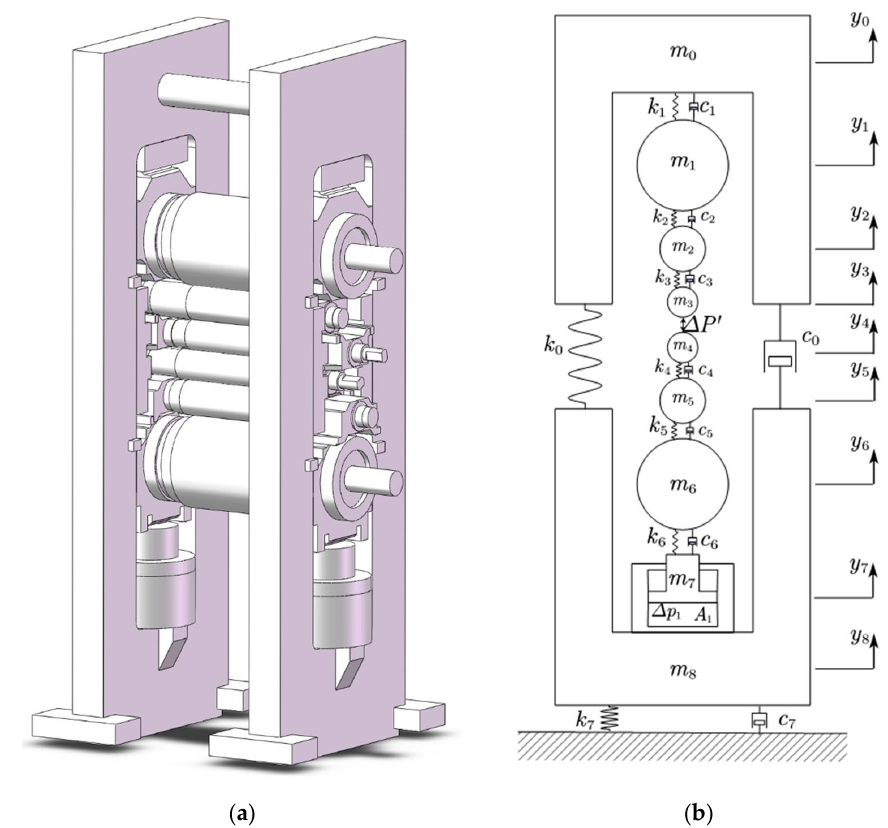
Figure 1. On − site vibration test diagram of upper and lower work rolls of cold rolling mill: ( a ) testing diagram in the factory; ( b ) spectrum diagram of upper and lower work roll test.